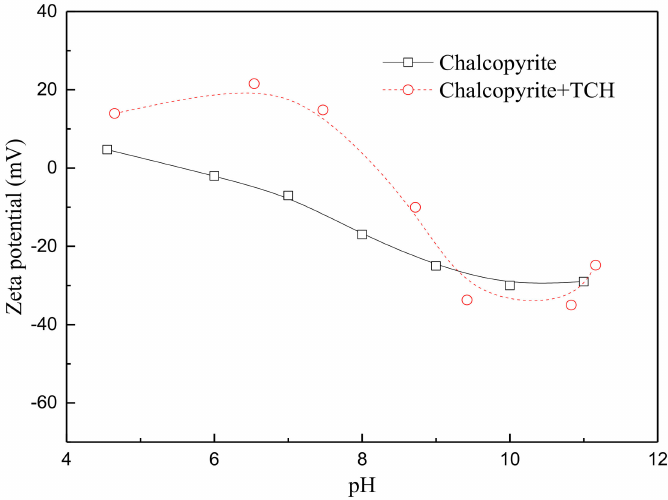
Figure 4. Zeta potential measurements of pure chalcopyrite as a function of pH in presence and absence of TCH (2 × 10 − 4